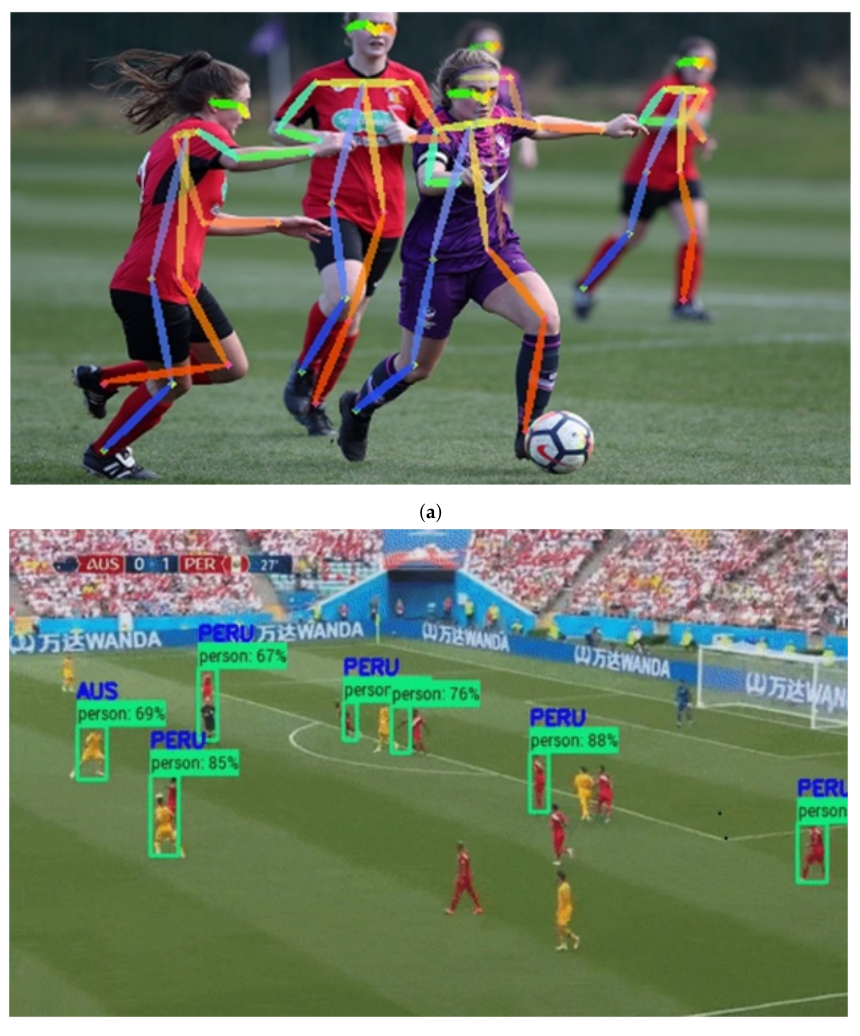
Figure 19. Instances from soccer matches. ( a ) Detecting body pose and limbs. ( b ) Handling severe occlusions among